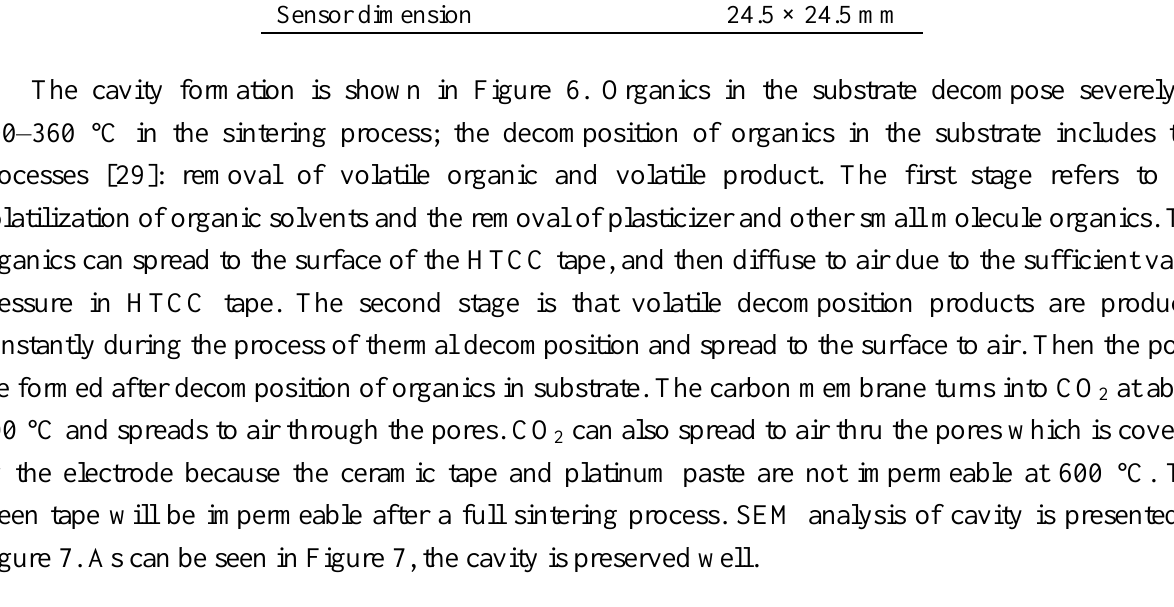
Figure 6. Formation of cavity: The carbon membrane turns into CO through the pores